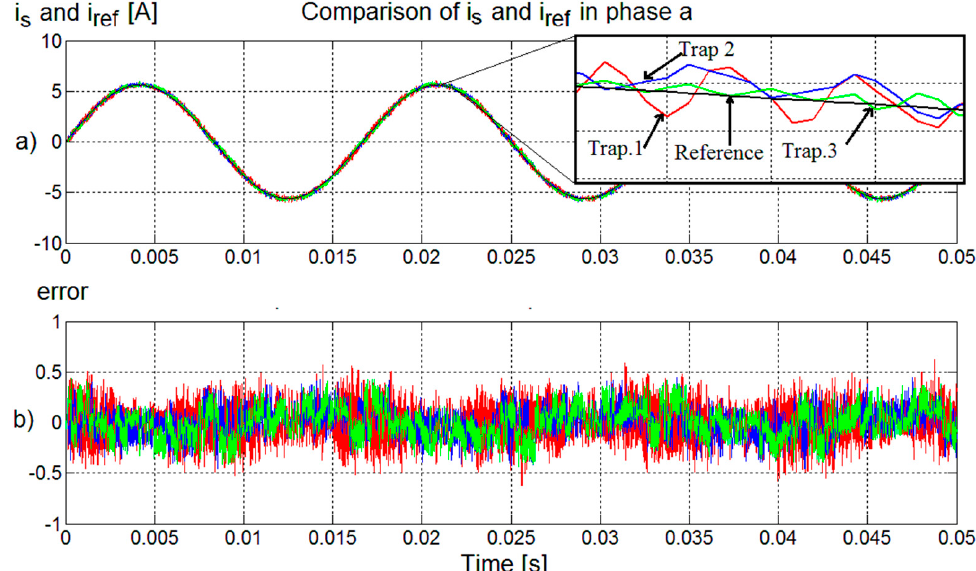
Figure 10. Comparison of i s and i ref in phase a for compound trapezoidal methods ( a ) Reference source current waveform, i ref , and measured current waveform, i s , in phase a using first ‐ , second ‐ , and third ‐ order trapezoidal approximations, for Ts = 10 μ s; ( b ) error magnitude. Table 3. Mean square error between i s and i ref in phase a for the evaluation of numerical methods in the predictive controller.